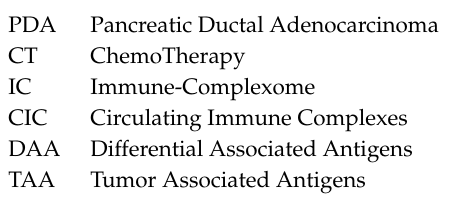
Table S6: EnrichR results. A. Analysis of combined IgA, IgM and IgG differential recognized